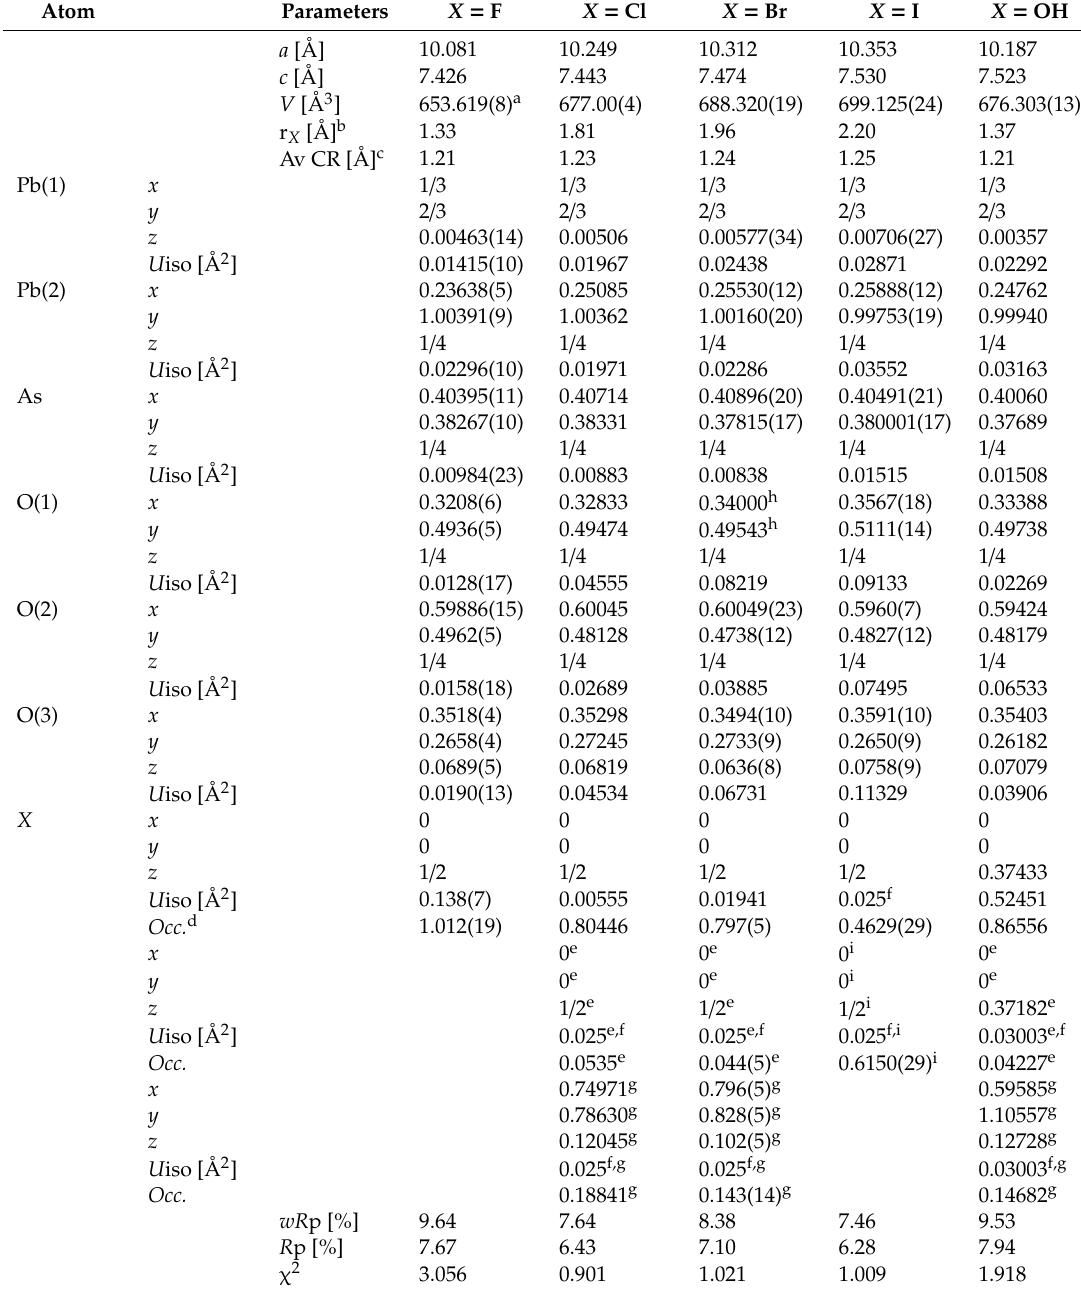
Table 2. Summary of structural Rietveld refinements of substituted mimetites Pb 5 (AsO 4 ) 3